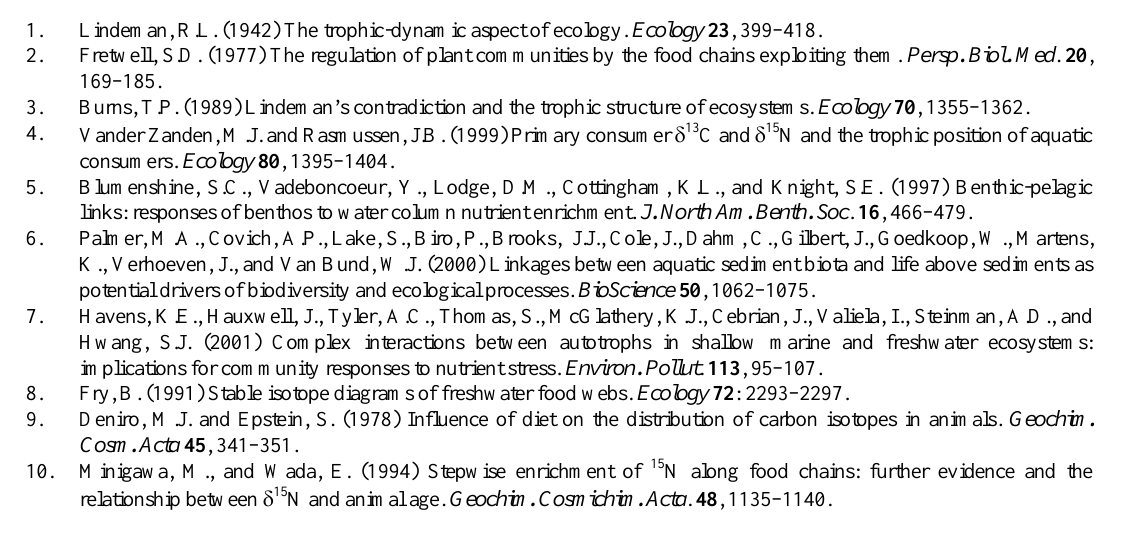
FIGURE 4. Average δ 15 N values (+ one standard error) for fish ( A ), primary consumers ( B ), and the difference between fish and primary consumers ( C ) at the four sampling sites in Lake Okeechobee. The horizontal lines indicate the inferred position of trophic levels (TL) 2, 3, and 4 in the lake food web, assuming a 3.4 o /oo difference between trophic